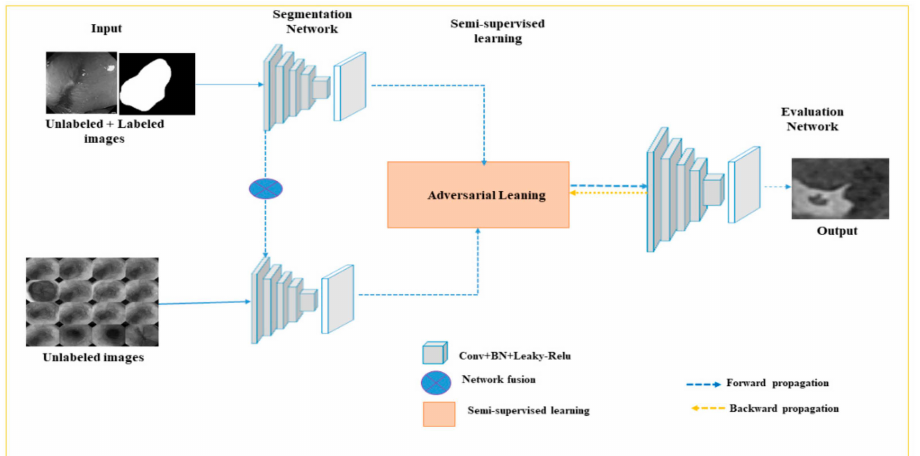
Figure 3. Overview of proposed semi-supervised GI lesion segmentation architecture. Initially, a segmentation network (SN) is applied by using labeled data and corresponding GT data in a fully supervised fashion. Then, an evaluation network (EN) is introduced to give different scores to the segmentation of unlabeled and unlabeled